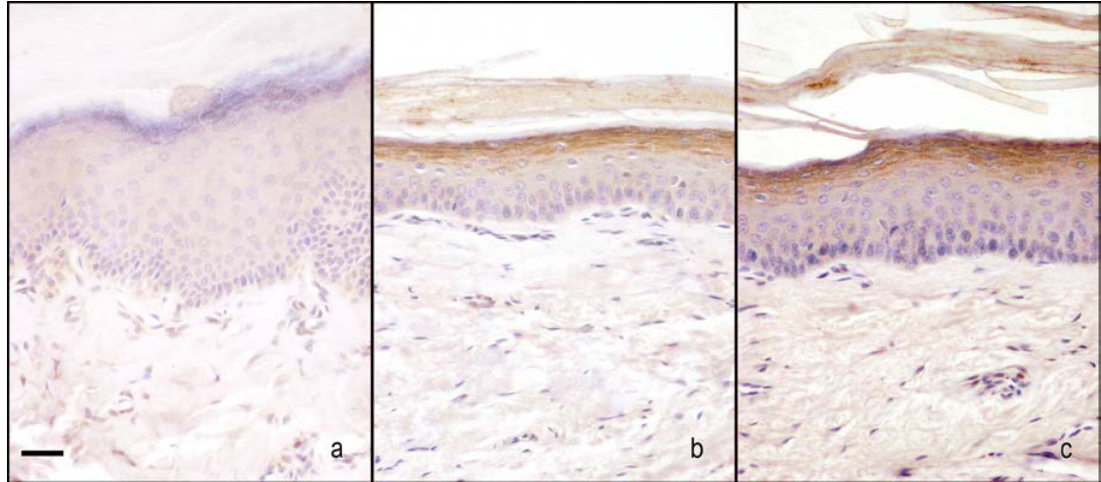
Figure 6. Microphotographs of nNOS immunostaining in plantar skin. Microphotographs of nNOS immunostaining in the epidermis of the right hind-paw plantar skin of sham-operated rats treated with 1% ethanol in saline (vehicle for melatonin) ( a ), CCI rats treated with 1% ethanol in saline (vehicle for melatonin) ( b ), and CCI rats treated with melatonin 10 mg/kg ( c ). Bar = 20 µ m. iNOS Staining